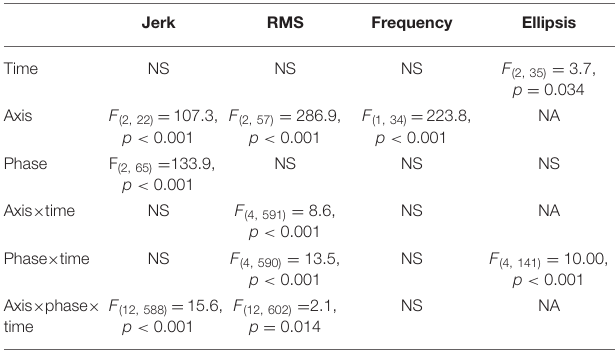
TABLE 2 | Mixed linear model results for single and interaction effects of time (18, 36, and 54 months), axis (combined, mediolateral, anteroposterior) and phase (30, 60, 120s) on gait accelerometry